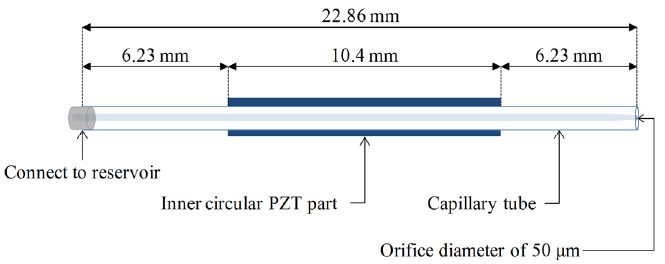
Figure 2. Dispenser head geometry.